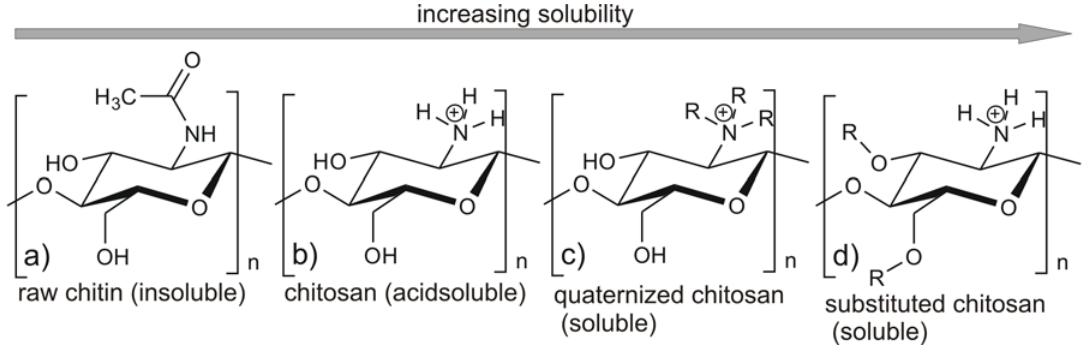
Figure 1. Schematic representation of chitin and chitosan derivatives. Through functionalization of the chemical structure, the solubility of the almost insoluble biopolymer chitin (a) can be enhanced. Quaternized (c) and substituted (d) derivatives also show much better solubility under alkaline conditions than chitosan (b)